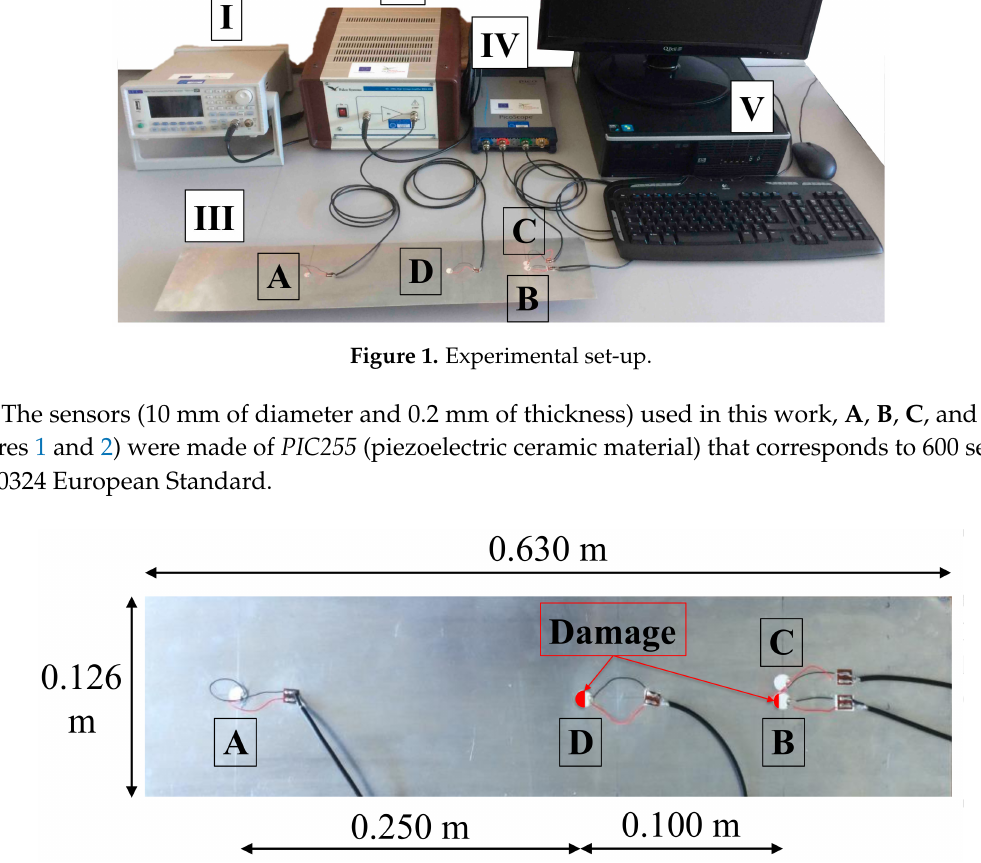
Figure 2. Sample